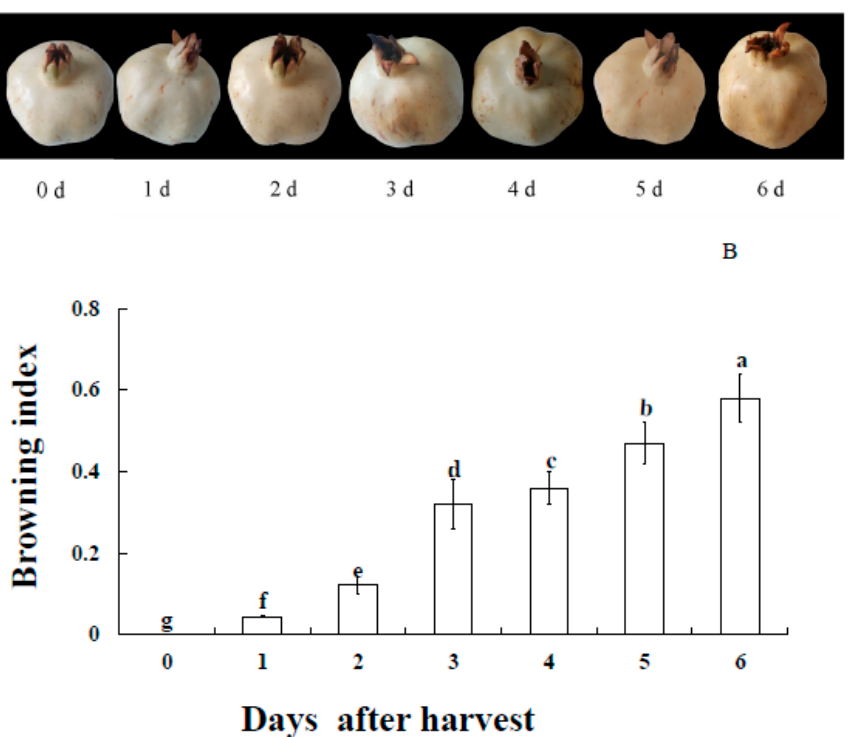
Figure 1. Fruit stored at room temperature (25 ± 2 ◦ C) for 0 to 6 d and the browning index (BI) of pericarp. ( A ) Fruit stored at room temperature (25 ± 2 ◦ C) for 0 to 6 d. ( B ) Browning index (BI) of pericarp of fruit stored at room temperature (25 ± 2 ◦ C) for 0 to 6 d. Vertical lines represent the standard deviation of the means of three replicates. Different small letters indicate a significant difference at p <